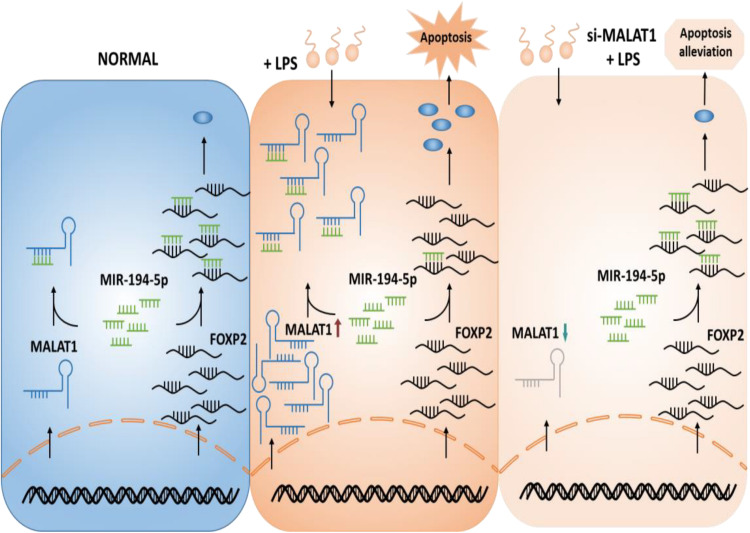
Hypothetical model of the function of MALAT1 in ALI. MALAT1 acts as a sponge of miR-194-5p. Knockdown of MALAT1 alleviates apoptosis of LPS-stimulated HPAEpiC by restoring FOXP2 expression. ALI, acute lung injury; LPS, lipopolysaccharide.